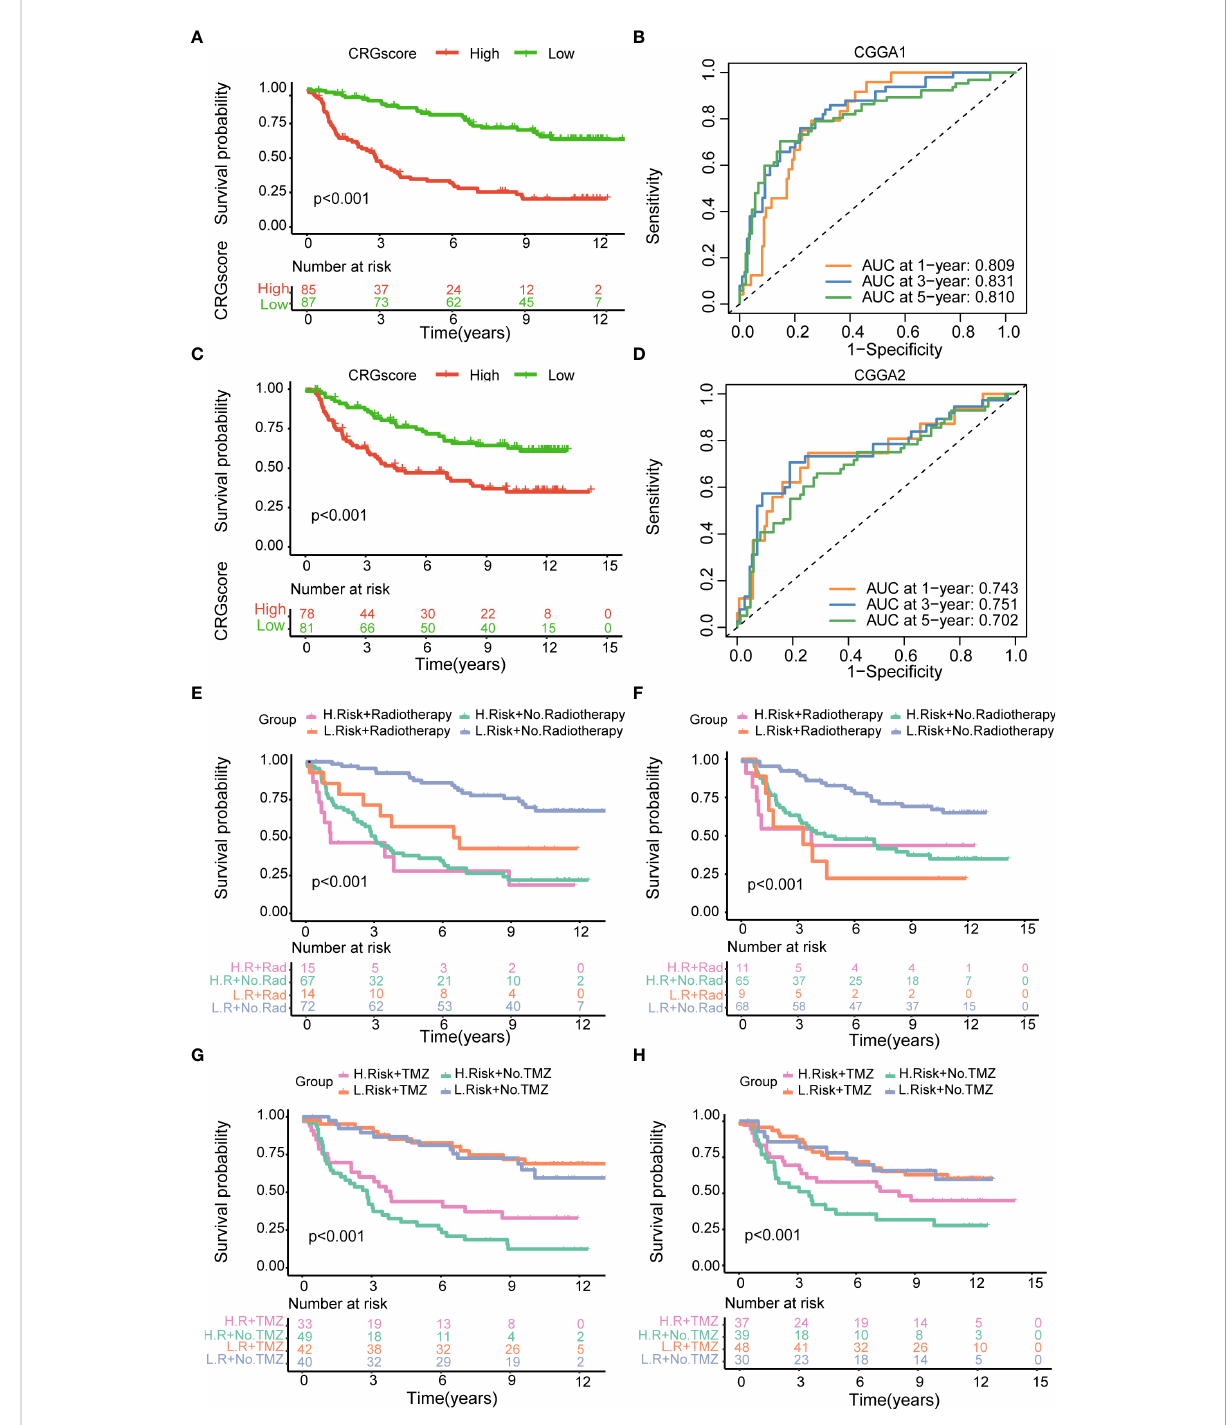
FIGURE 7 Validation of the cuproptosis-related prognostic model in CGGA cohorts. (A) The Kaplan – Meier OS curves for patients in the high- and low-risk groups in the CGGA1 cohort. (B) The Kaplan – Meier OS curves for patients in the high- and low-risk groups in the CGGA2 cohort. (C) ROC curves showed the prognostic performance of the cuproptosis-related prognostic model in the CGGA1 cohort. (D) ROC curves showed the prognostic performance of the cuproptosis-related prognostic model in the CGGA2 cohort. (E – G) The Kaplan – Meier OS curves among four groups classi fi ed by the CRG score and treatment with radiotherapy in CGGA1 and CGGA2 cohorts. (G – H) The Kaplan – Meier OS curves among four groups classi fi ed by the CRG score and treatment with TMZ in CGGA1 and CGGA2 cohorts. CGGA, Chinese Glioma Genome Atlas; ROC, receiver operating characteristic; OS, overall survival; TMZ, temozolomide; CRGs, cuproptosis-related